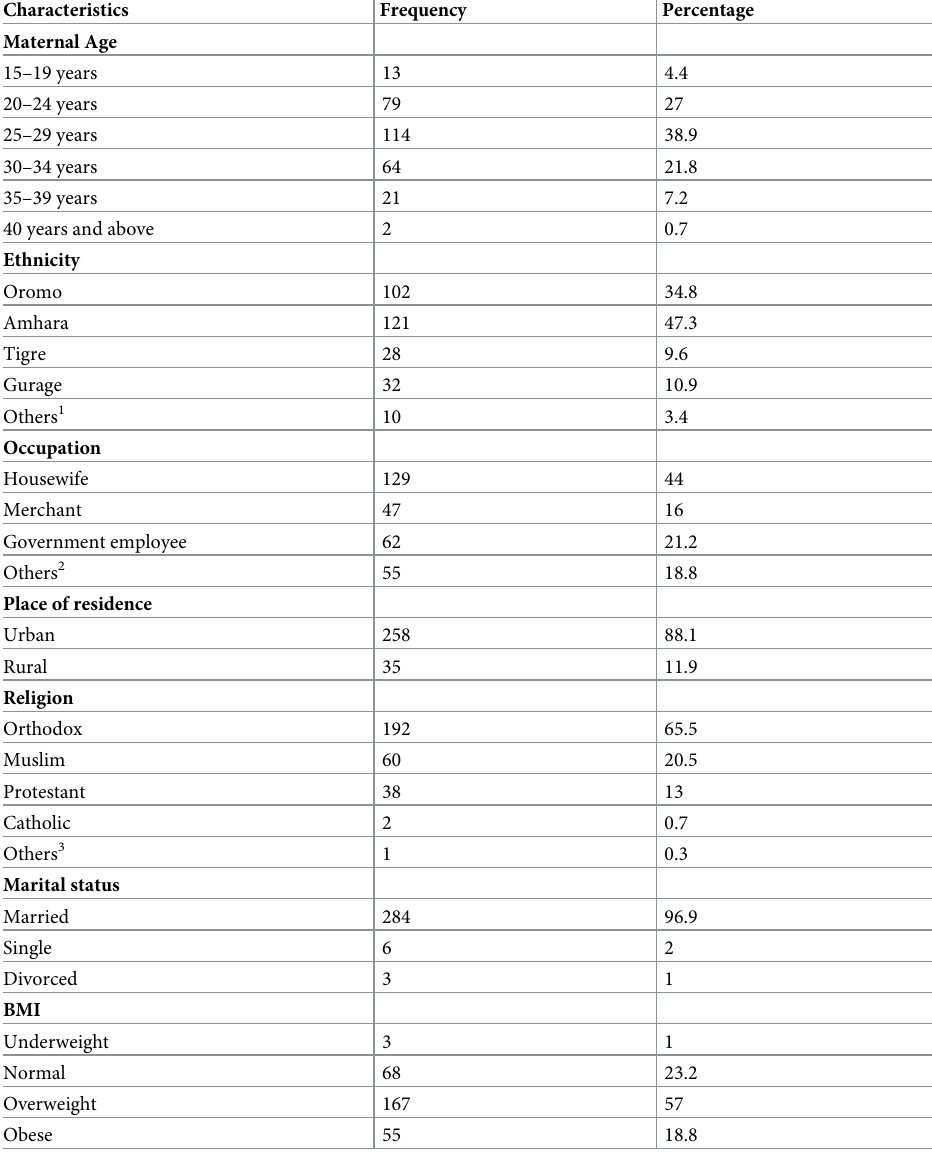
Table 1. Distribution of socio-demographic characteristics of the study participants in Adama hospital medical college, 2020 (n = 293).